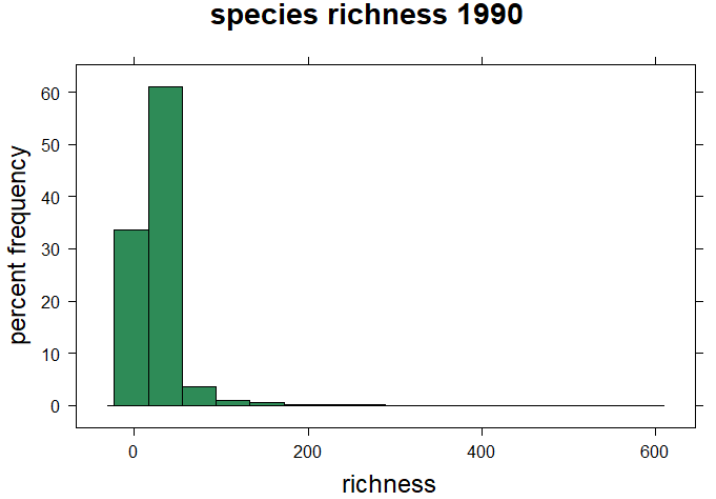
Figure 2. Frequency of species richness in the Czech Republic. The distribution is based on 1117 representative species, each with at least 50 observations.